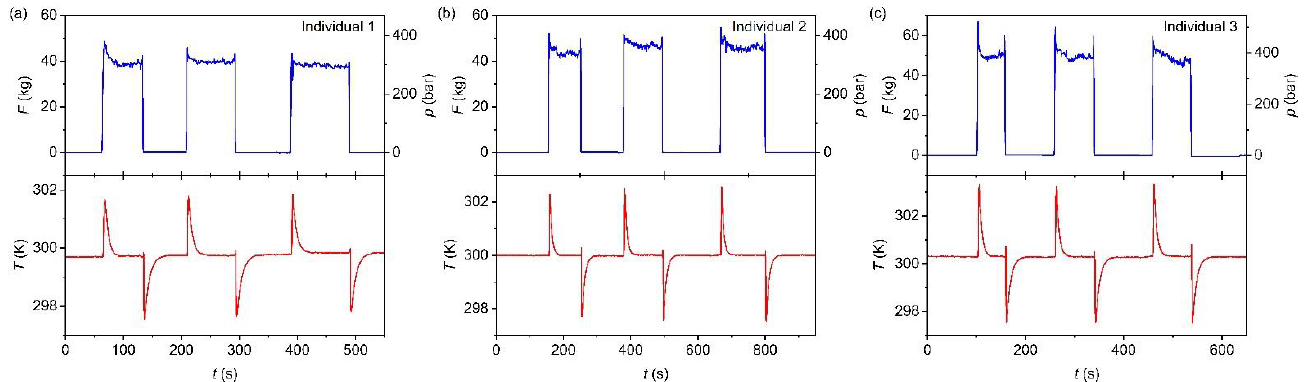
Figure 3. Selected curves of force and pressure (blue curves) and temperature (red curves) as a function of the cyclic footsteps of individual ( a ) 1, ( b ) 2, and ( c ) 3 with a bodyweight of 61.8 kg, 71.9 kg, and 85.0 kg, respectively.